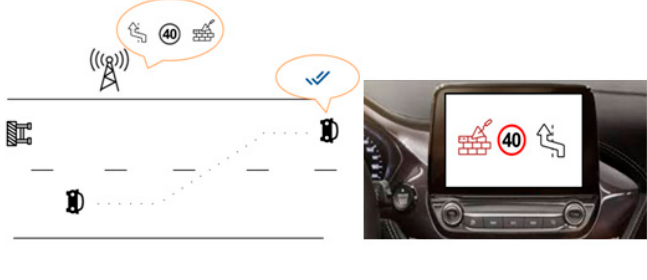
Figure 2. Operation example .